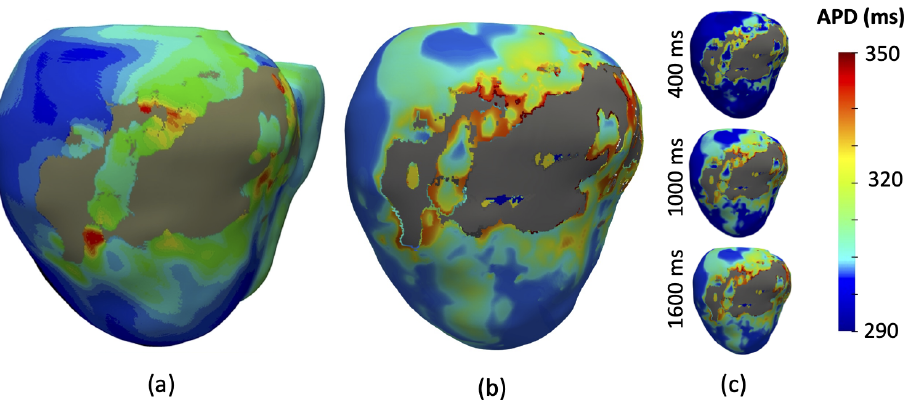
Figure 8. APD maps on the epicardial surface. APD map after S1 pacing protocol (BCL = 600 ms) for ( a ) biophysical simulation and ( b ) CA simulation. ( c ) shows the evolution of the APD after each of the first three stimuli for the CA model. Color represents the APD at each node. CZ is depicted in gray